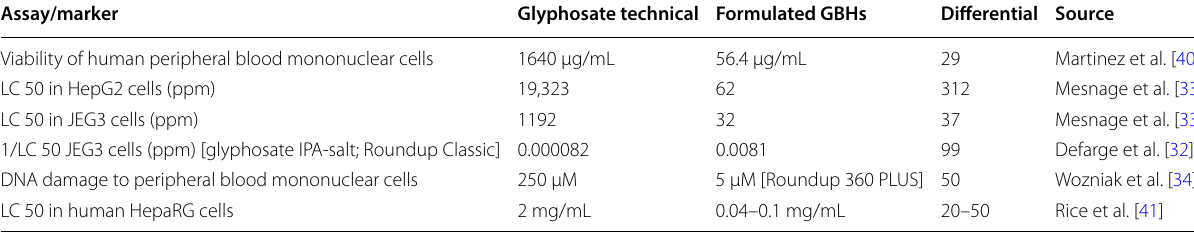
Table 3 Examples of the differential toxicity of technical glyphosate and formulated GBHs in human cell assays